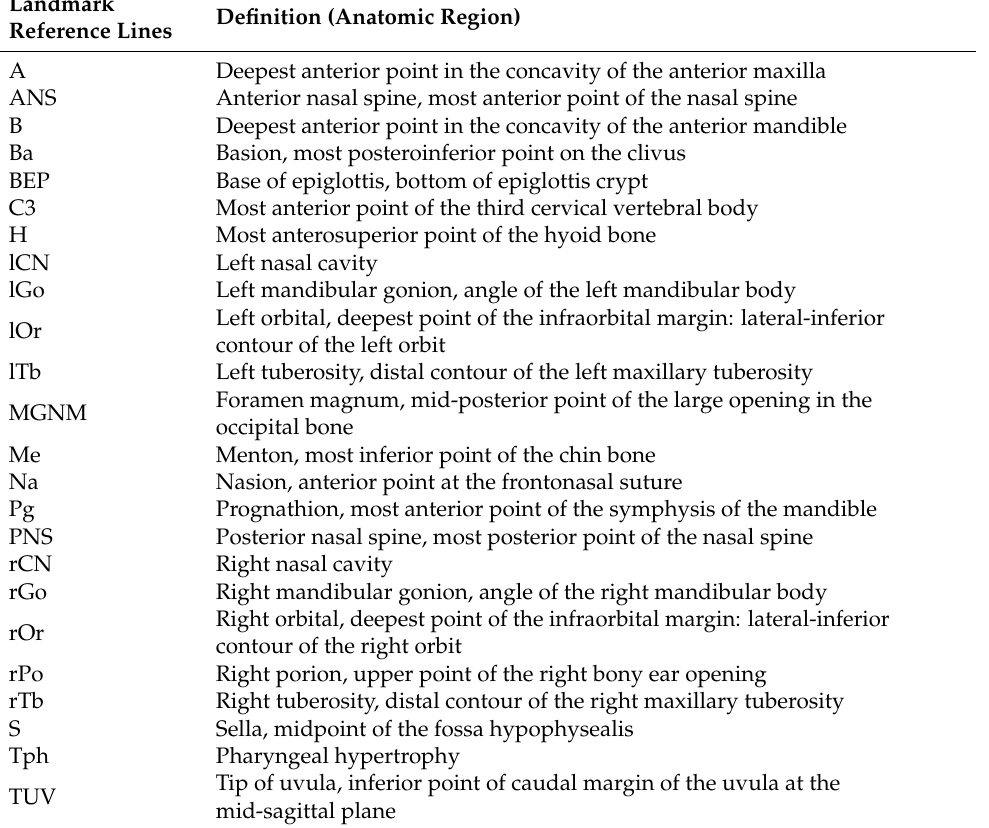
Table 1. Definitions of the anatomical